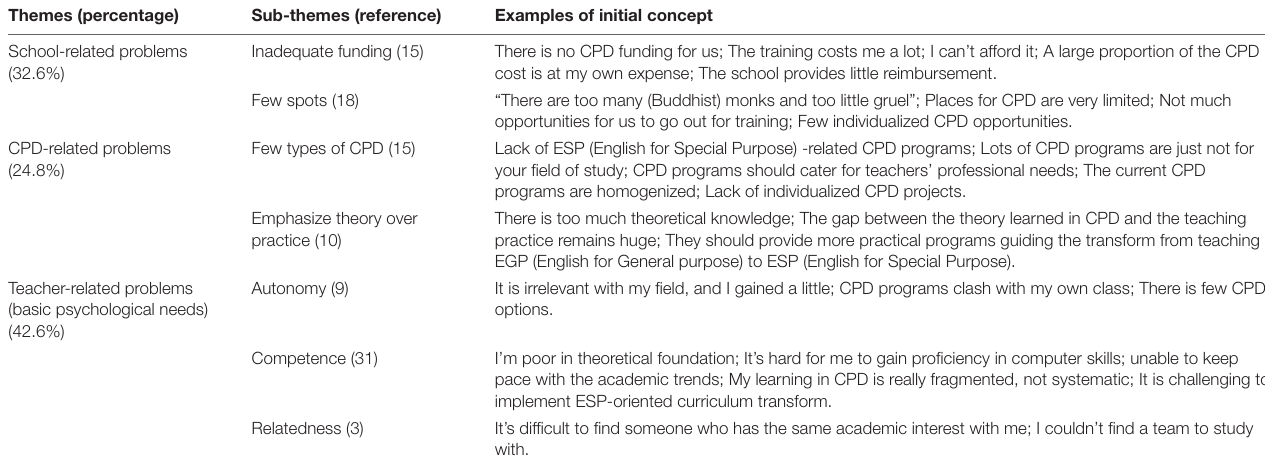
TABLE 6 | Difficulties and challenges teachers encountered in CPD. Themes (percentage) Sub-themes (reference) Examples of initial concept School-related problems